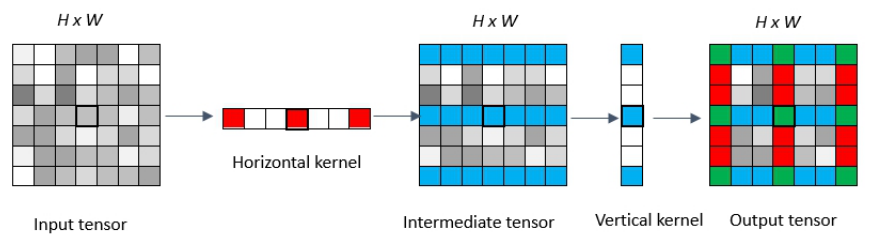
Figure 2. The vertical convolution is a dilated convolution with kernel size of ( 3,1 ) , the dilated factor l is ( 2,0 ) ; the horizontal convolution is a dilated convolution with kernel size of ( 1,3 ) , the dilated factor is ( 0,2 ) . The blue grid represents the feature values activated by the vertical convolution kernel. The red grid represents the feature values activated by the horizontal convolution kernel, and the green grid represents the feature values activated by both horizontal and vertical convolution